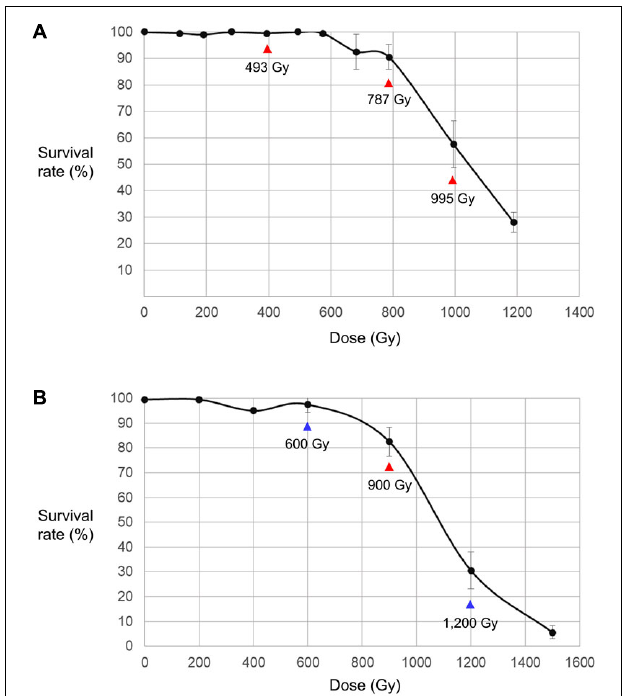
FIGURE 1 | Relationship between irradiation dose and survival rate of M 1 individuals. (A) Dose–survival rate relationship in proton beam-irradiated individuals. (B) Dose–survival rate relationship in gamma-ray-irradiated individuals. The samples irradiated at the doses indicated by red arrows were used for both the phenotypic analysis and whole genome sequencing. The samples irradiated at the doses indicated by blue arrows were used only for the phenotypic